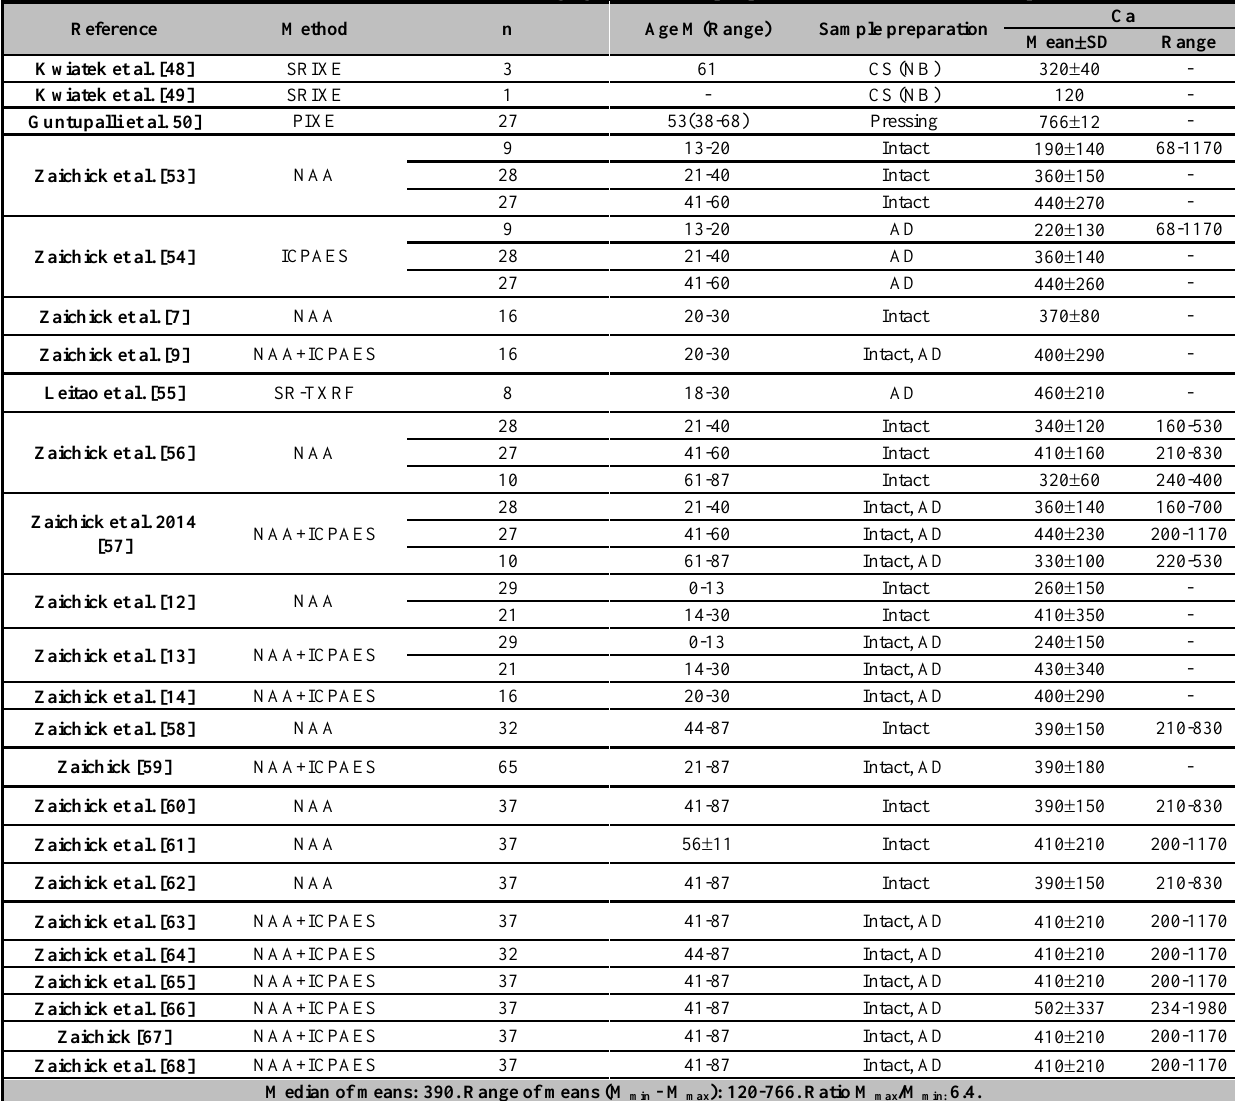
Table 3. Reference data of Ca mass fractions (mg/kg wet tissue) in peripheral zone of “normal” human